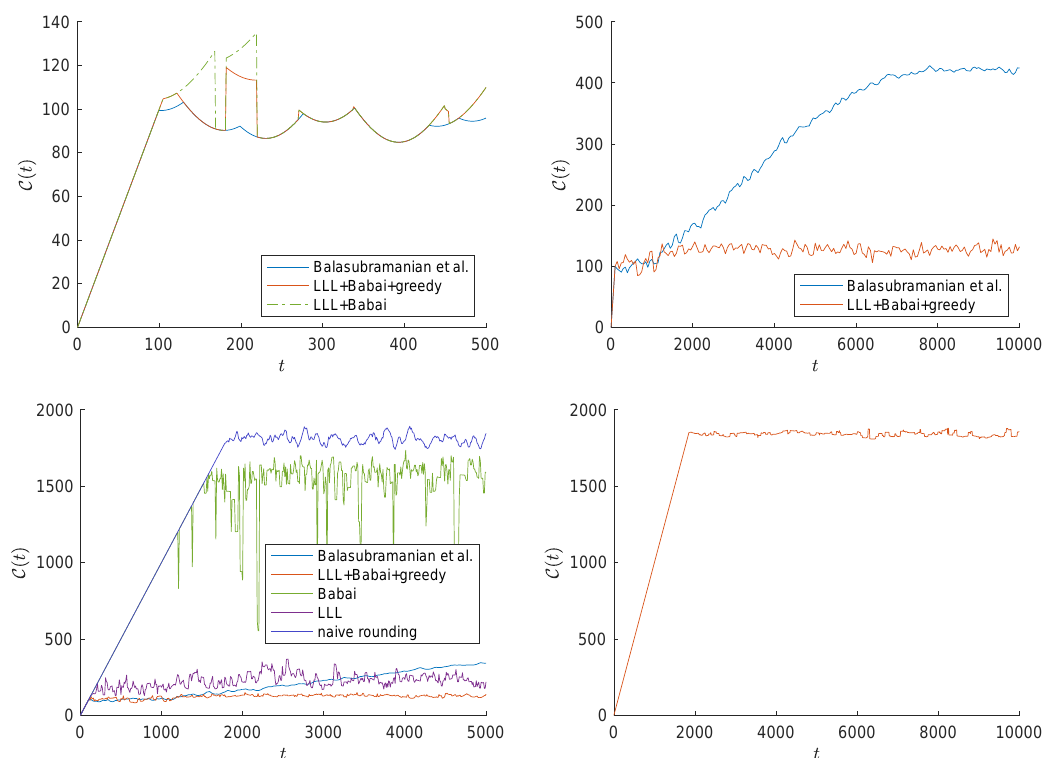
Figure 3: At the top, we display a comparison between the results of [ 21 ] (in blue) and the upper bound on complexity (3.17) proposed in the present paper (in red), for (left) a realization of the free SYK Hamiltonian with k = 2 (4.3). (right) a